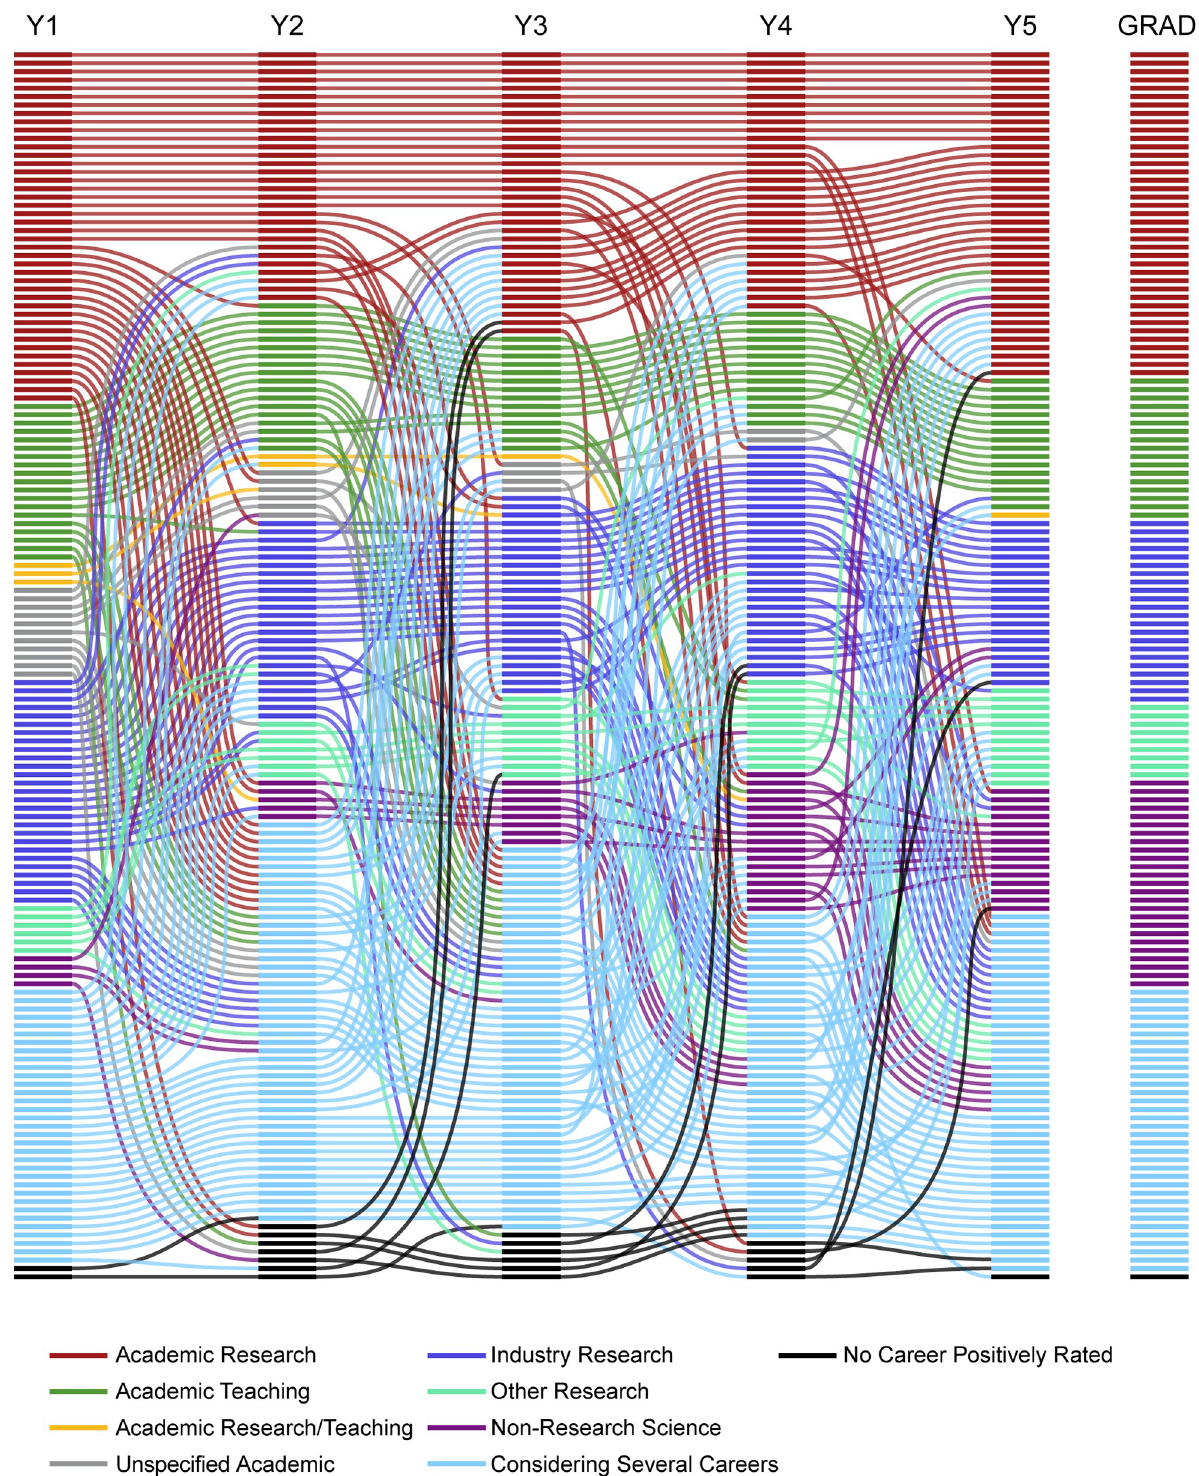
Fig 1. Change of career intention from start to finish of the PhD. This alluvial chart tracks the primary career intentions of 147 participants from the first year of a PhD program through graduation. Each column represents a time point separated by a one-year interval, with “Y1” representing the start of the first year of a PhD program and “Grad” reflecting the year of graduation. Each horizontal line represents an individual, with each color corresponding to a career type. Following a line left to right reveals the trajectory of an individual’s primary career intentions over time. The color of